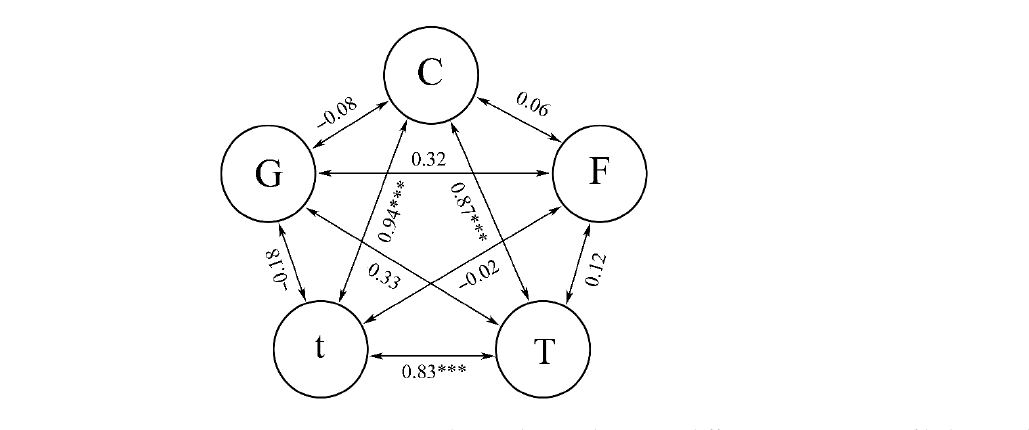
Figure 9. Retention time after the first grasp of pellets flavored with amino acids, ended with swal ‐ lowing or refusal of the pellet by barramundi Lates calcarifer . Differences between trials completed with each amino acid are significant at p < 0.001 for all substances (Mann–Whitney U ‐ test). Whiskers are the s.e.m.